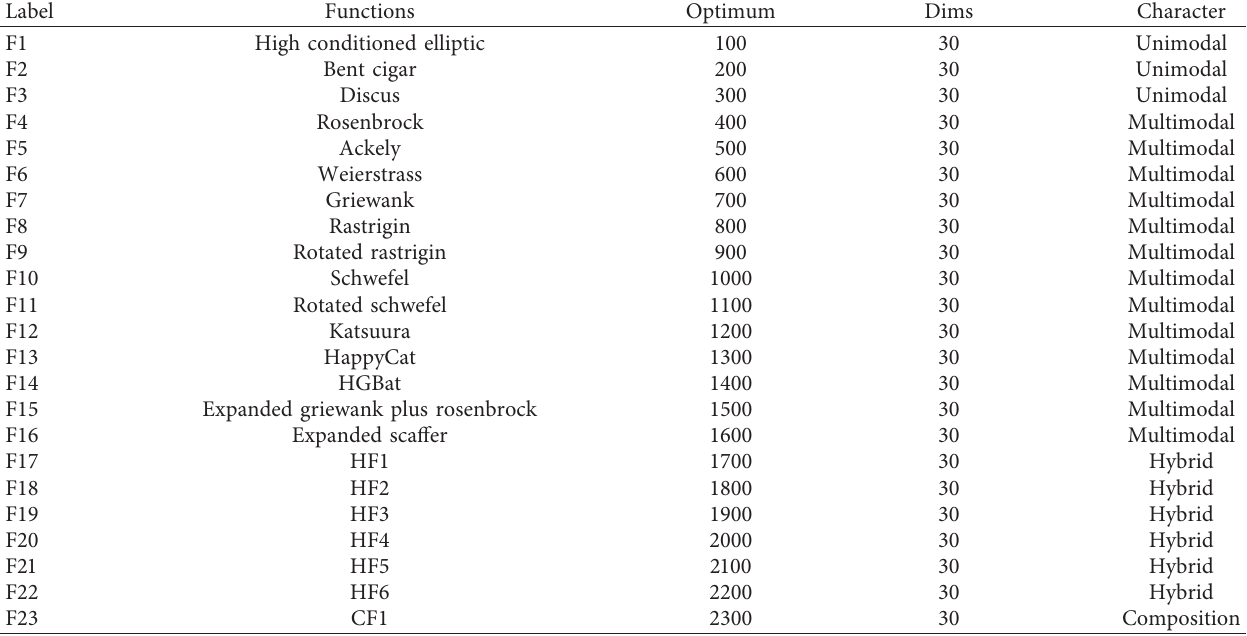
Table 1: Benchmark functions provided by CEC 2014 test set.